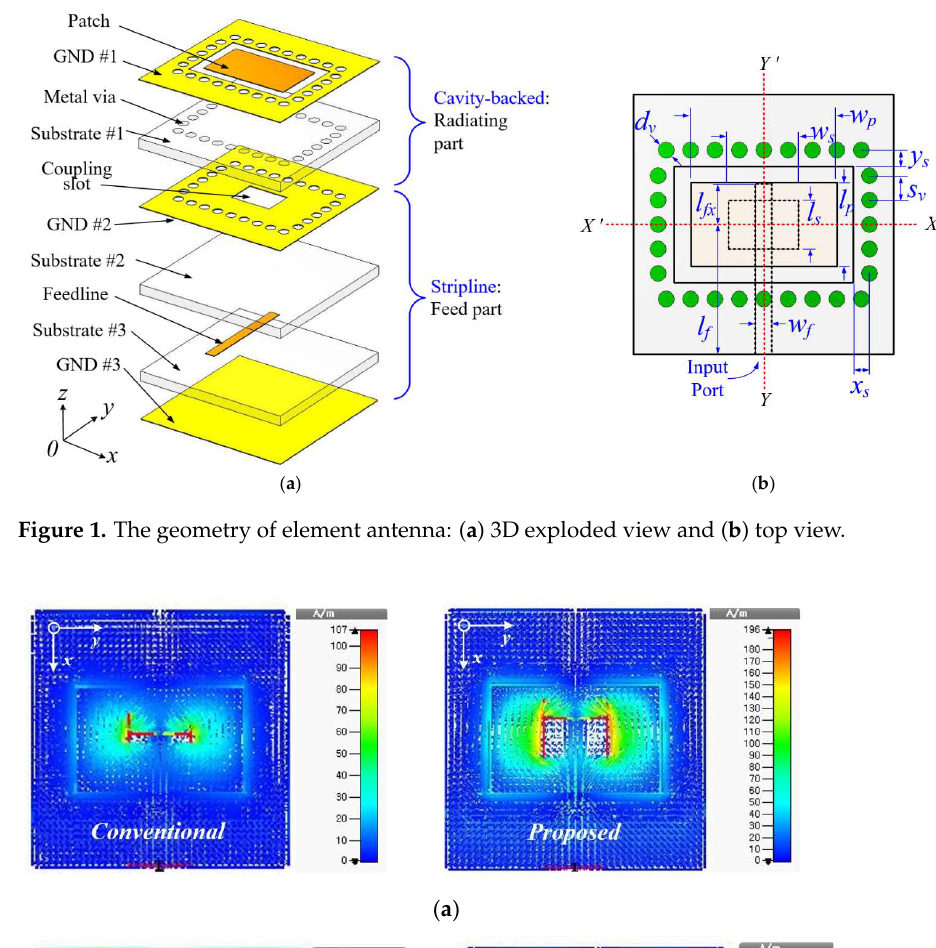
Figure 1. The geometry of element antenna: ( a ) 3D exploded view and ( b ) top view.